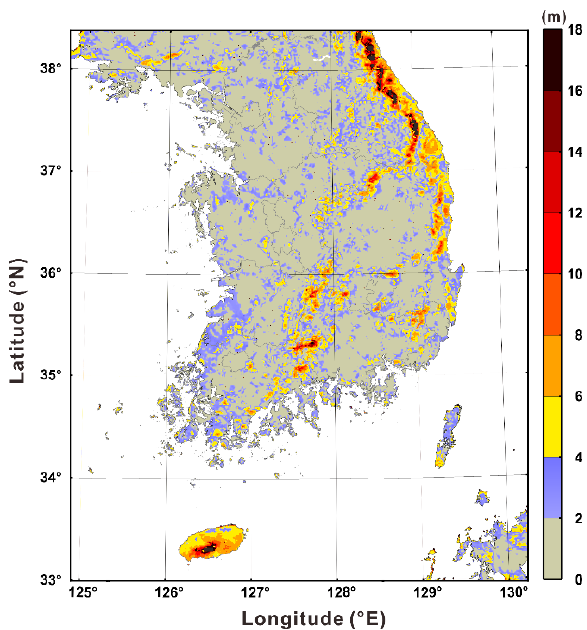
Figure 9. Distribution of increment rotor diameter for compensating for AEP loss.